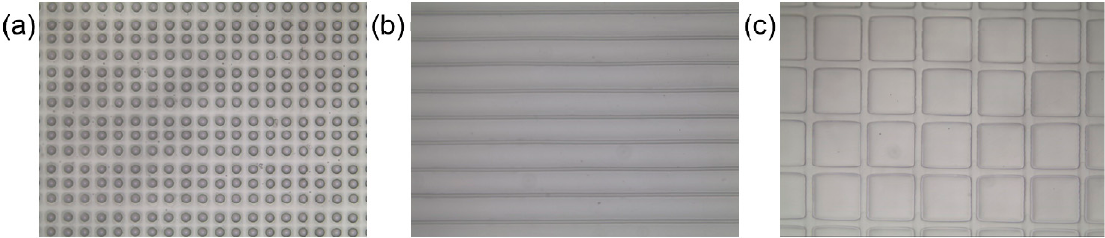
Figure 3. Morphologies of fabricated microstructured surfaces based on the etched template. ( a ) The microstructured surface with raised dot. ( b ) The microstructured surface with raised line. ( c ) The microstructured surface with raised square. Scale bar: 200 μ m.